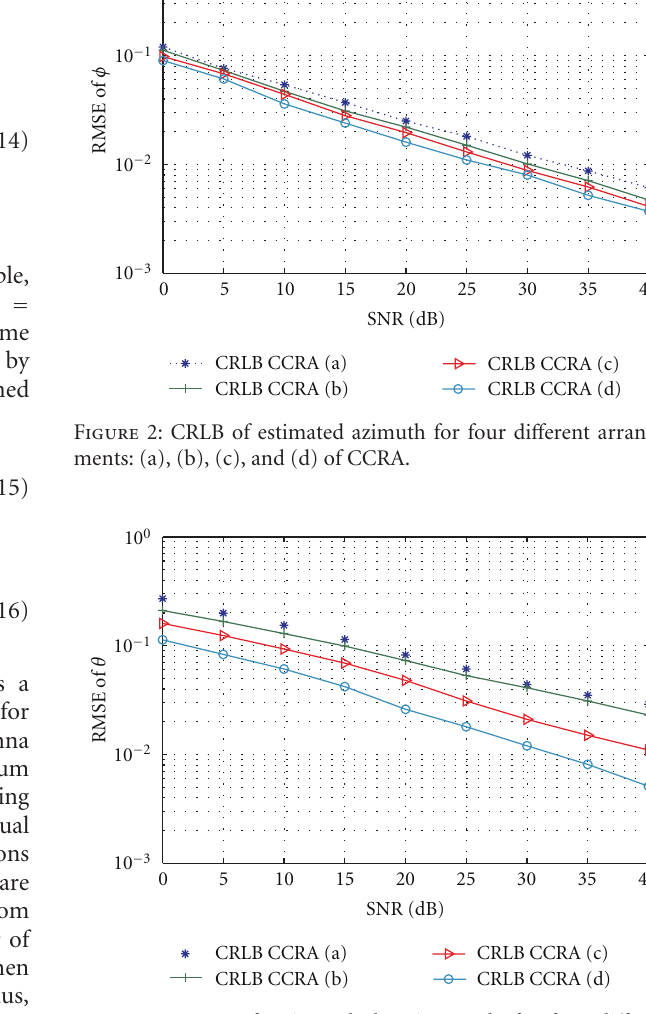
Figure 3: CRLB of estimated elevation angle for four di ff erent arrangements: (a), (b), (c), and (d) of